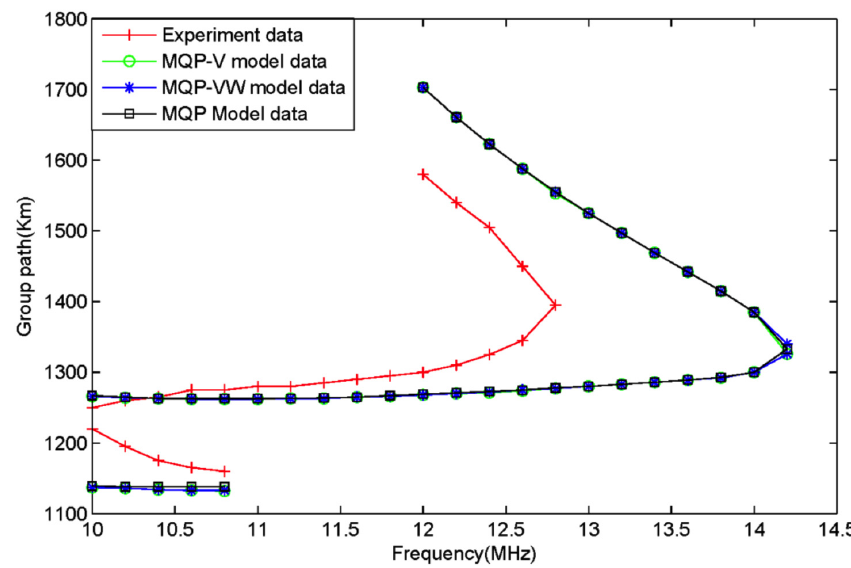
Figure 5. One-hop oblique sounding ionograms generated with the three MQP models and the experimental ionogram. Time: May 25, 2014, at 02:07 (UT).